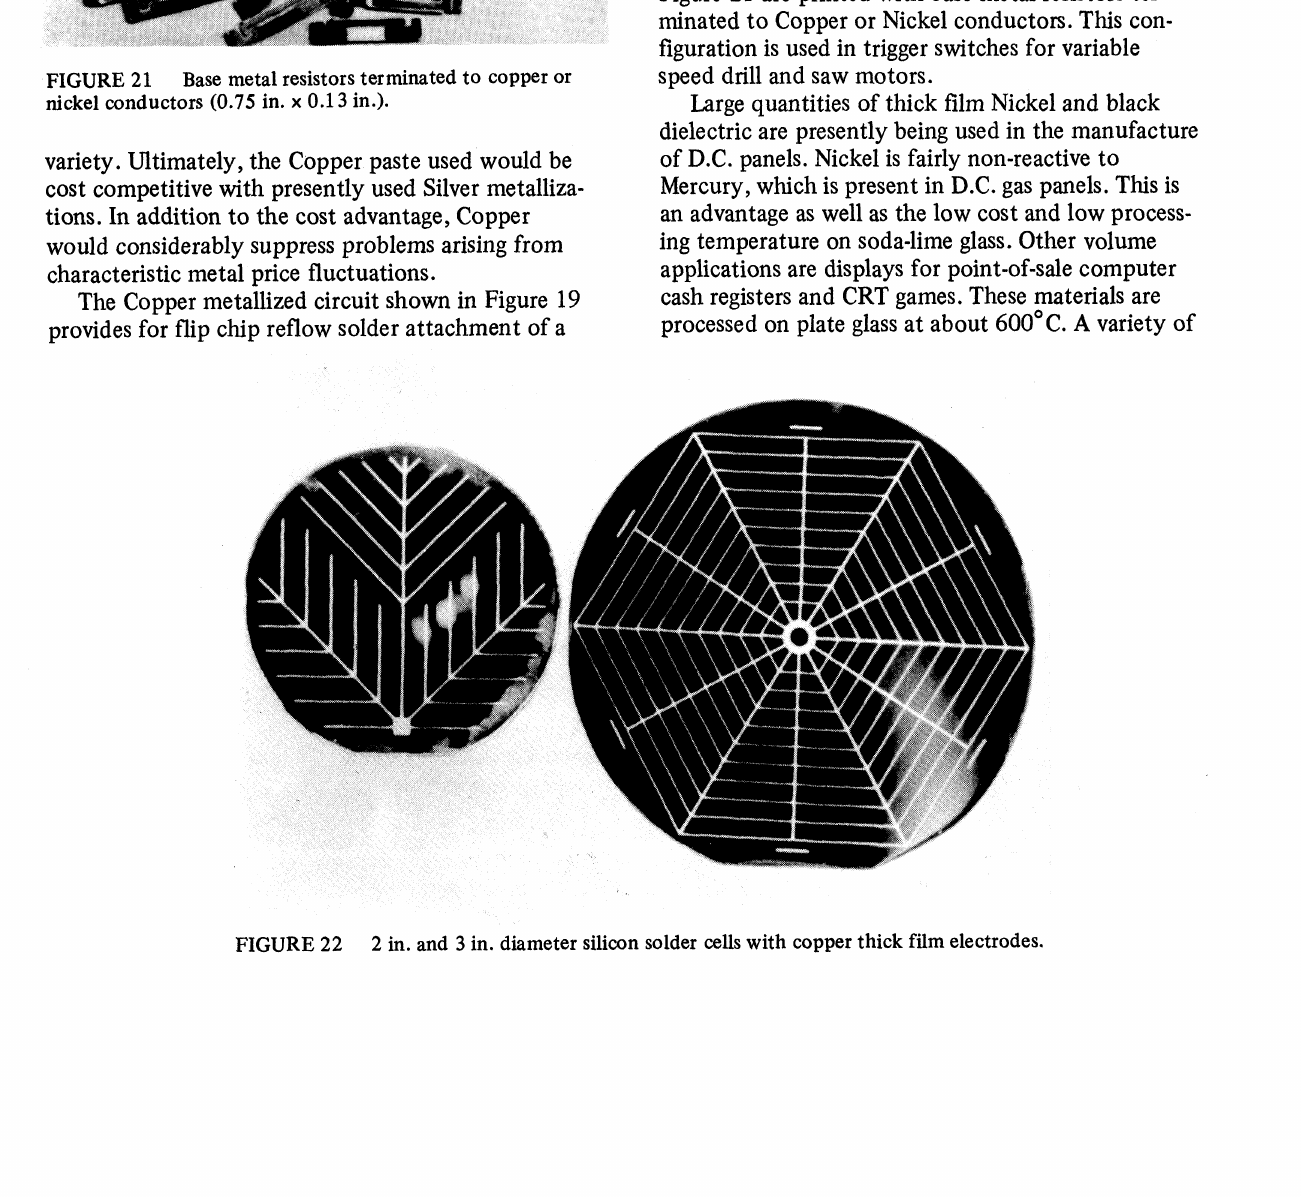
FIGURE 21 Base metal resistors terminated to copper or nickel conductors (0.75 in. x 0.13 in.).